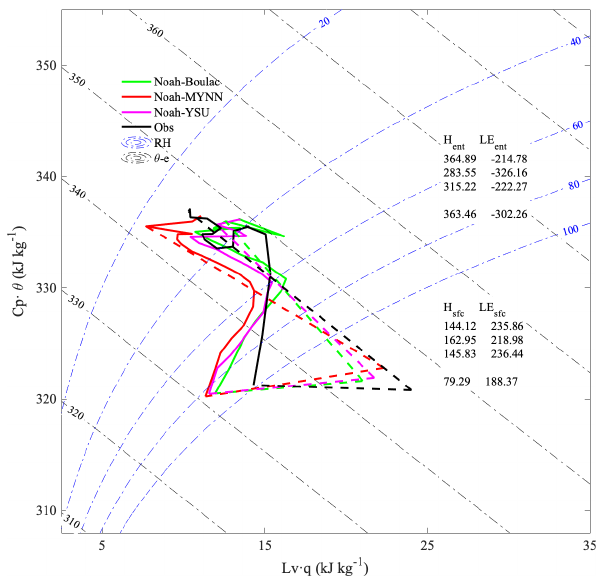
Figure 4. Mixing diagram at site BJ/Nagqu on 7 August 2011. Sim- ulated using Noah with different PBL schemes.